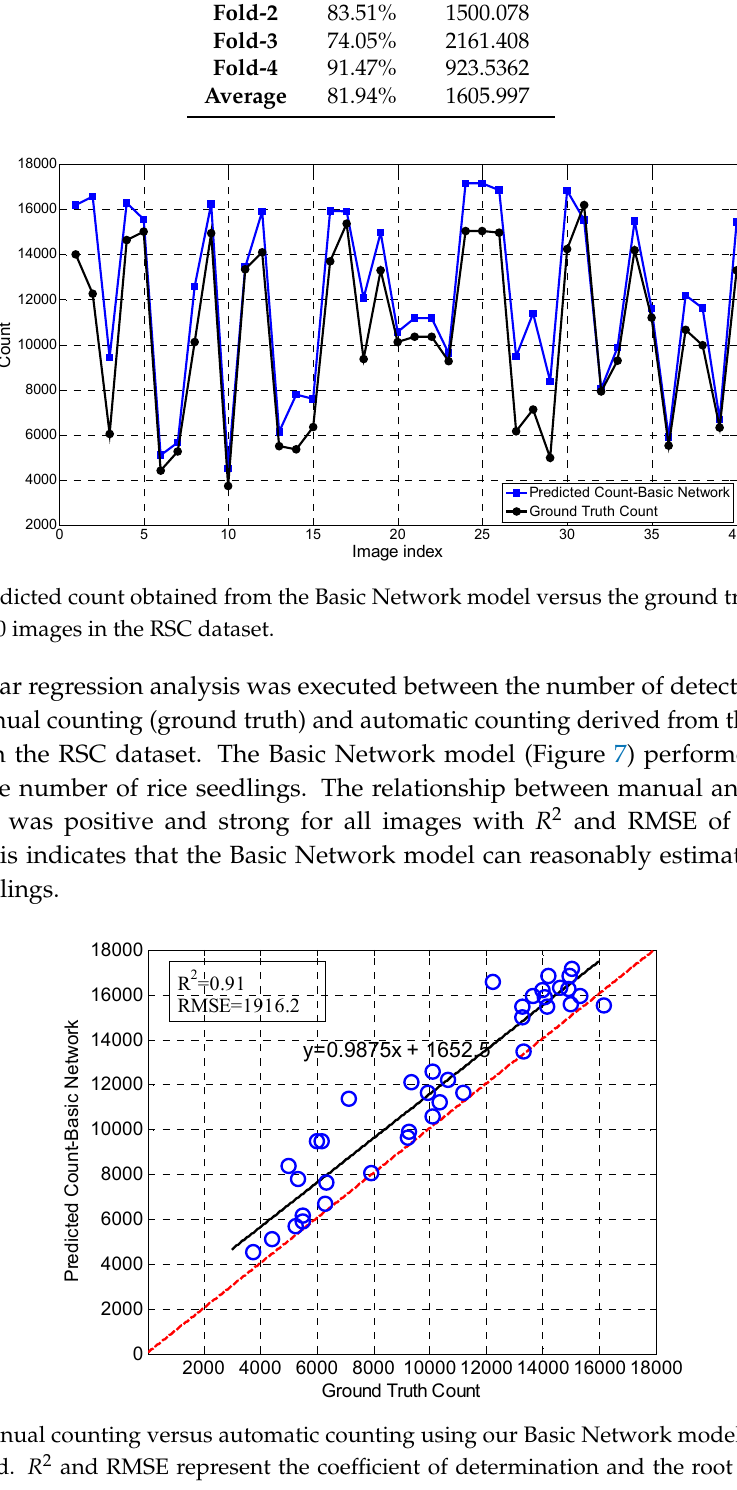
Table 1. Performance of the Basic Network on the RSC dataset.